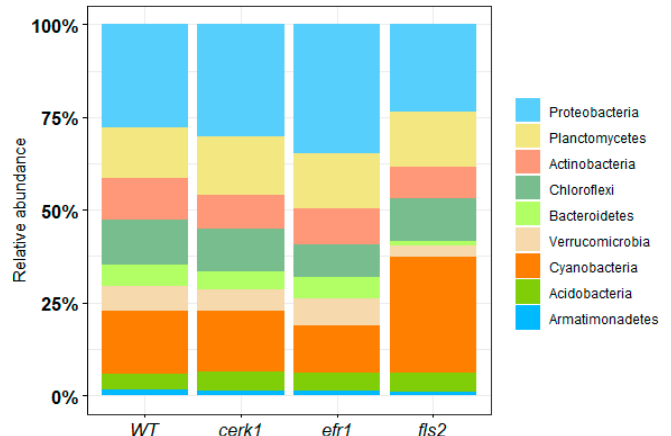
Figure 1. Relative abundance of the most represented enriched bacterial phyla from the rhizosphere of Arabidopsis PAMP mutants ( cerk1 , efr1 , and fls2 ) and the wild-type (WT; Col-0) grown in native soil from the Red River Farm (OK, USA). Bacterial phyla with <1% abundance were not included.